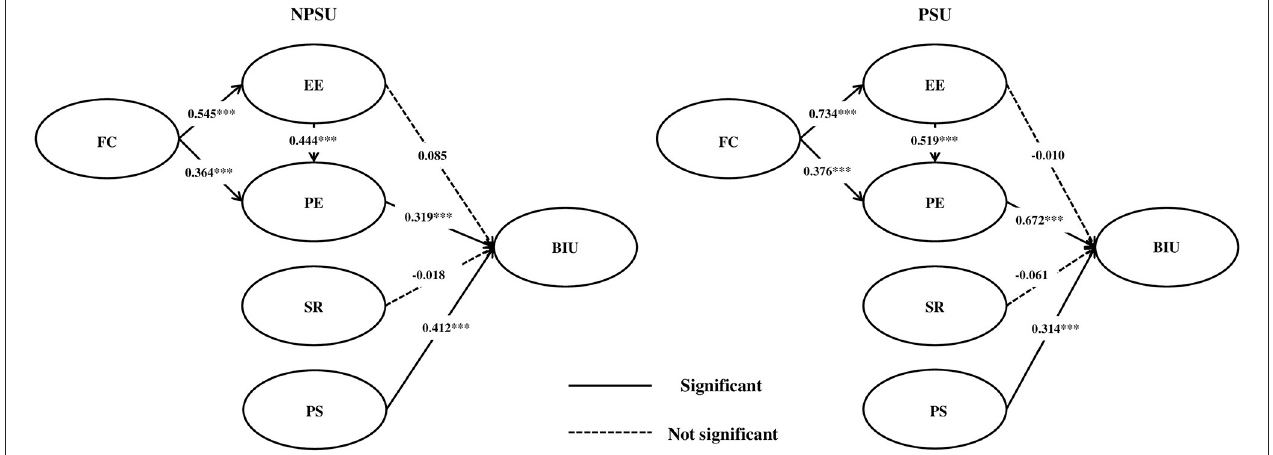
FIGURE 3 | Result of multigroup path